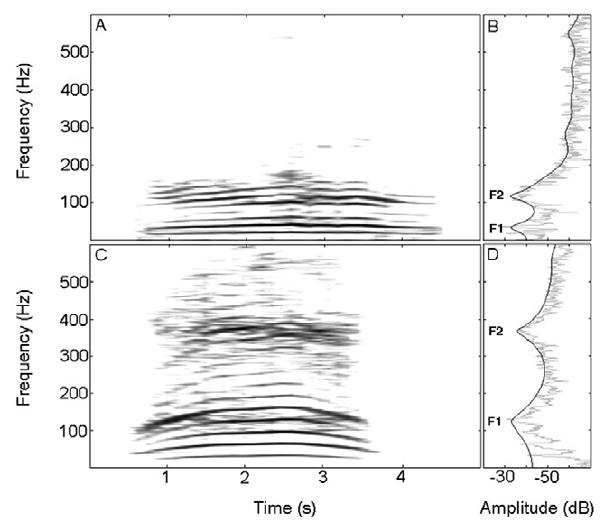
Figure 3. Spectral characteristics of nasal and oral rumbles. Spectrograms and power spectra showing an example of a nasal (A, B) and an oral (C, D) rumble, indicating formant positions (both rumbles uttered by Nuanedi, 10-year-old female).